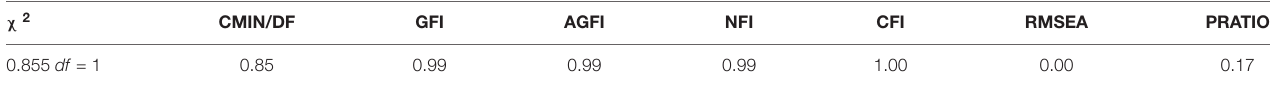
TABLE 2 | Fit index of the effort-reward model. χ 2 CMIN/DF GFI AGFI NFI